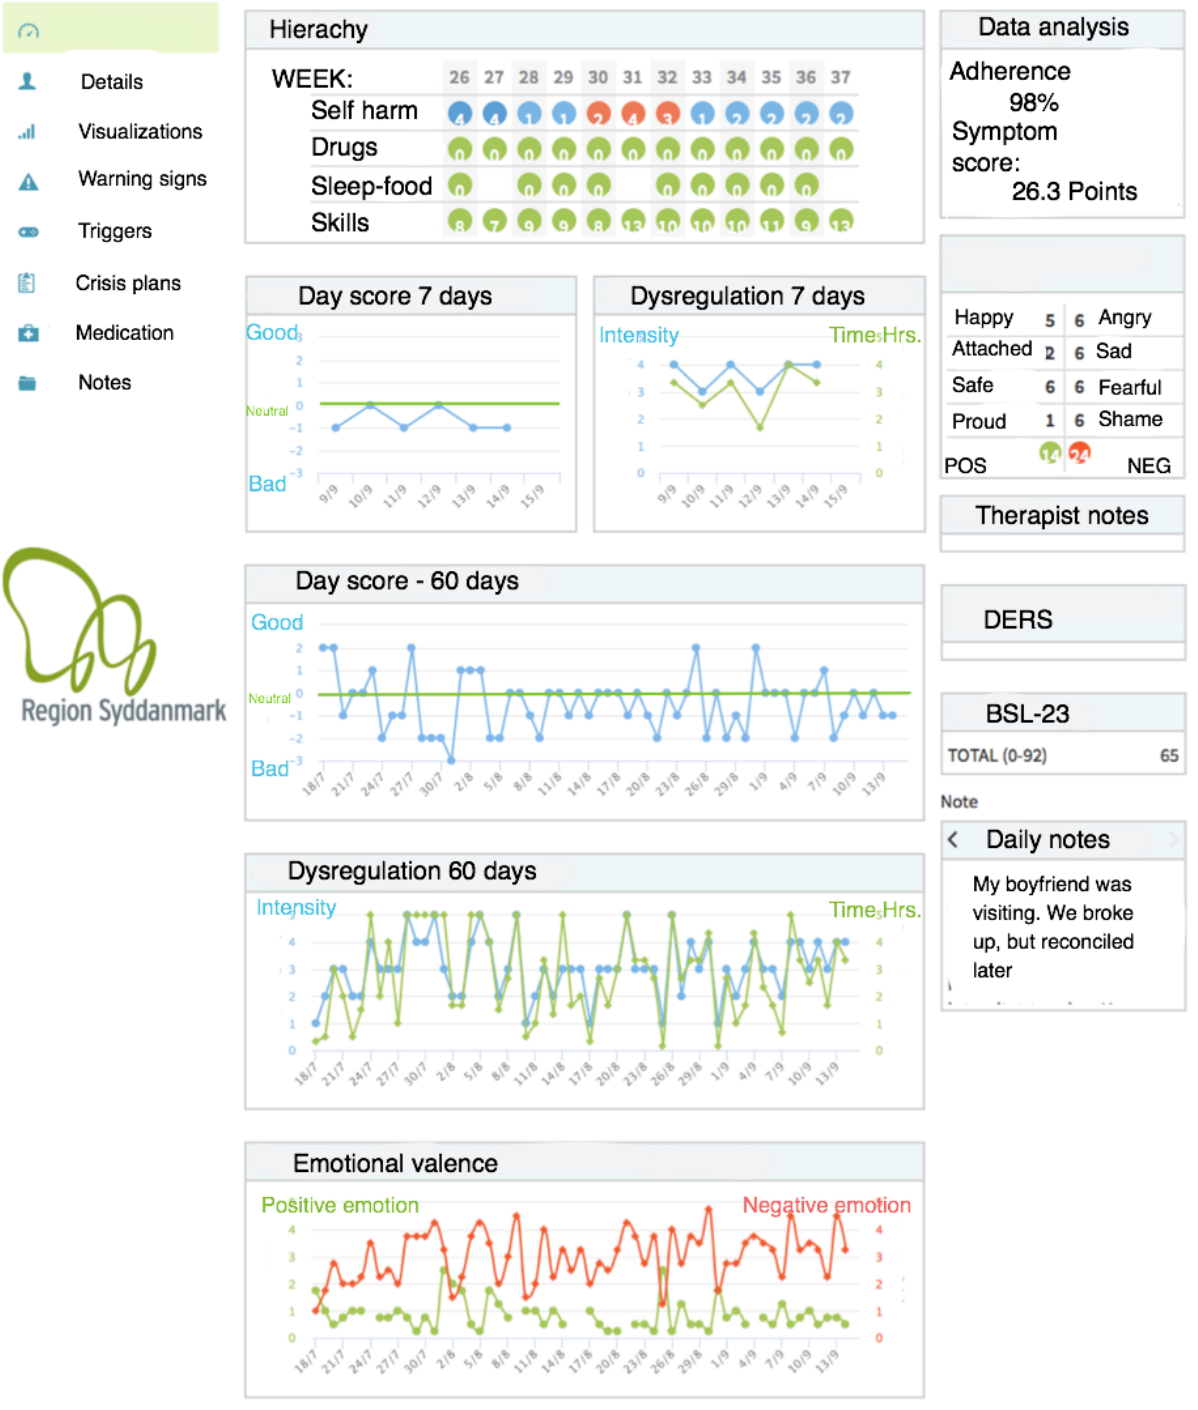
Figure 3. Overview screen for the therapy